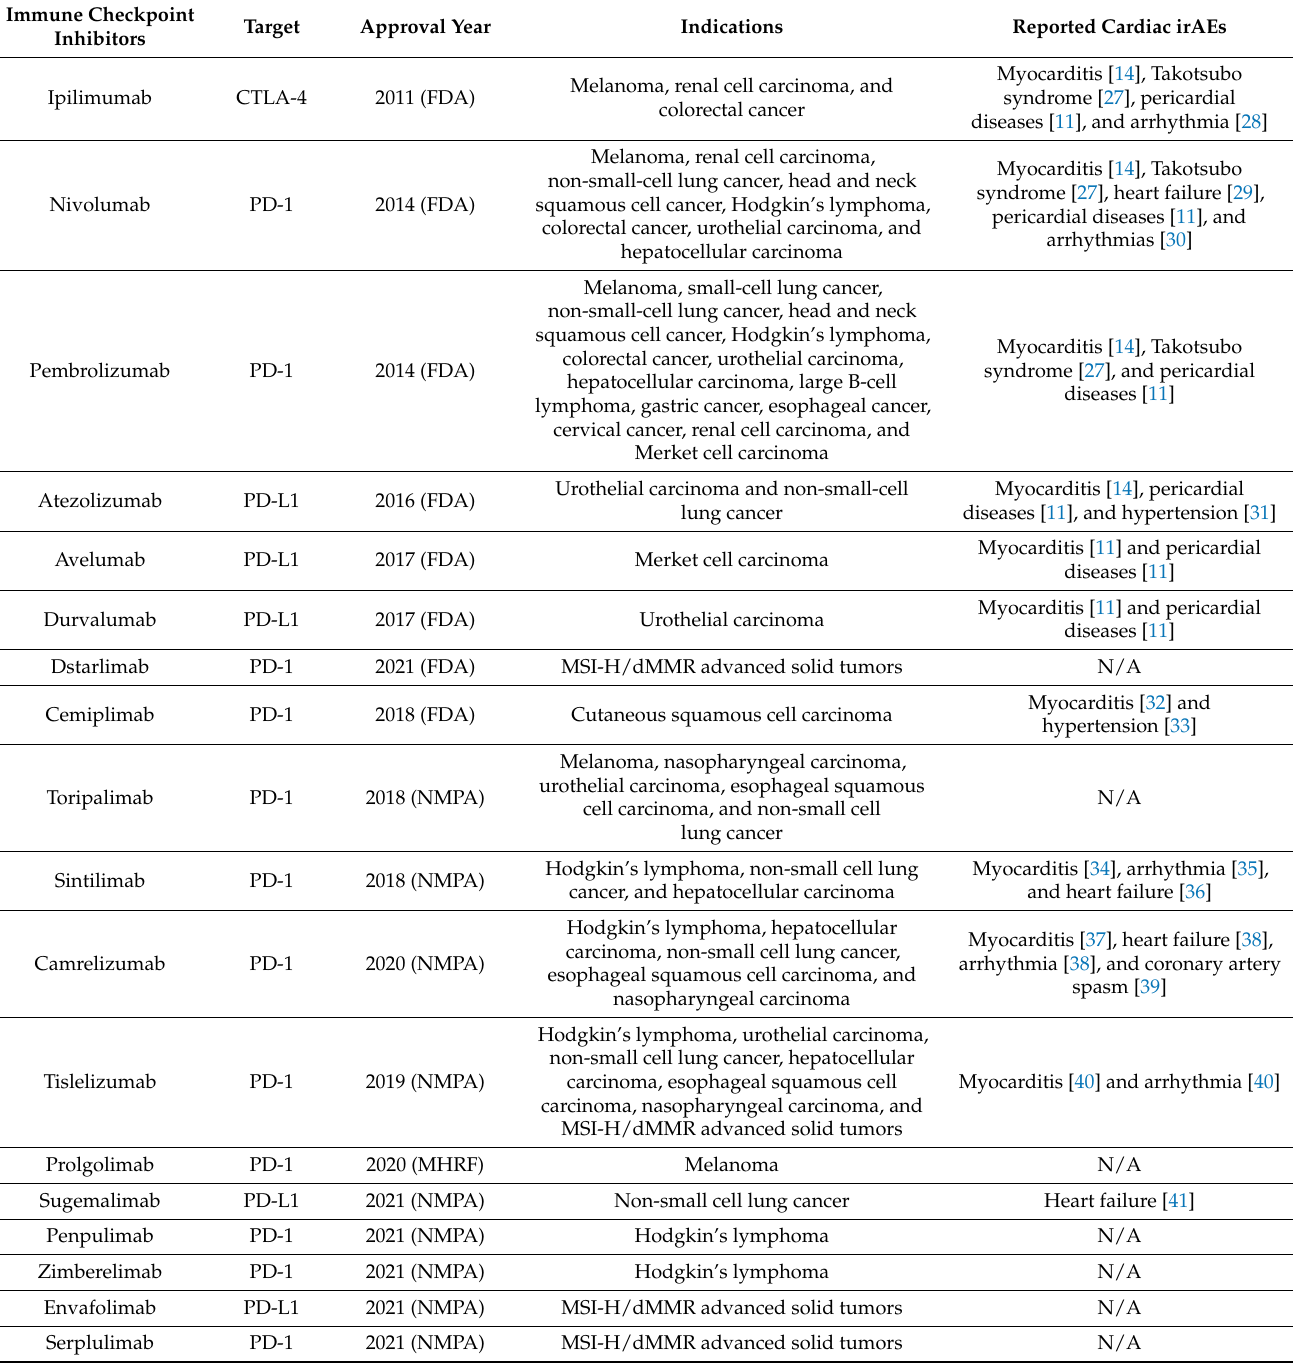
Table 1. Marketed ICIs